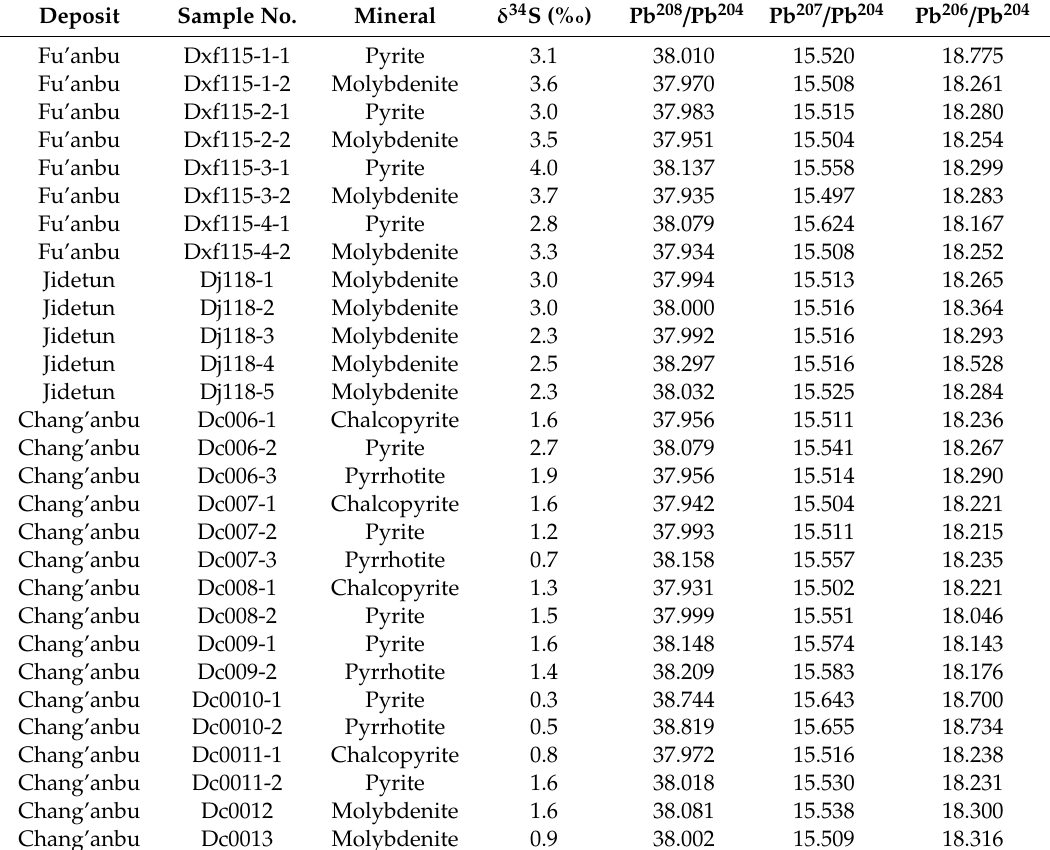
Table 2. S and Pb isotopic compositions of the Chang’anbu, Fu’anbu, and Jidetun ore